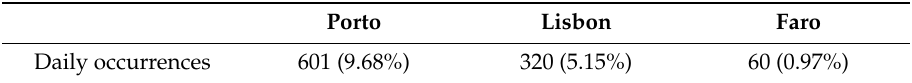
Table 2. Fog daily occurrences and relative frequency in the period 2002 to 2018, at the airports of Porto, Lisbon, and Faro.